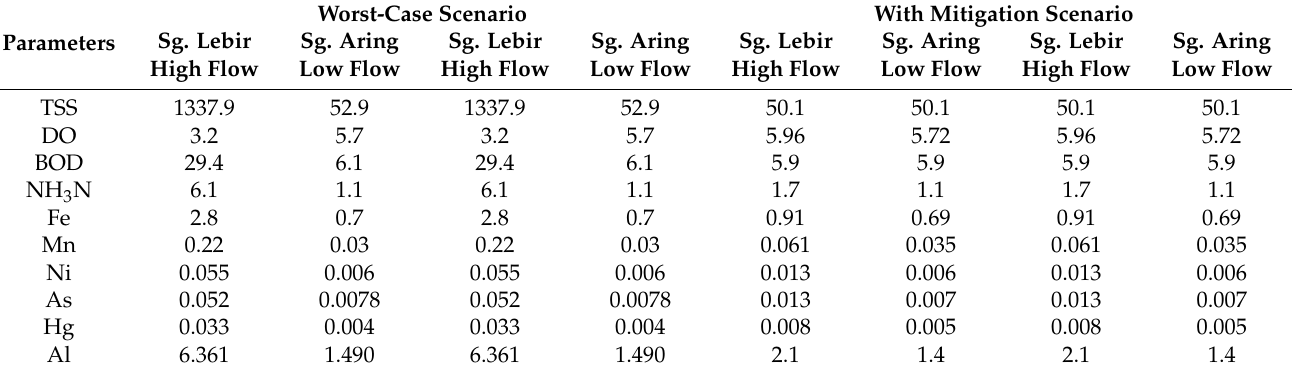
Table 6. Average results of all parameters (mg/L) in worst-case and with mitigation scenarios.